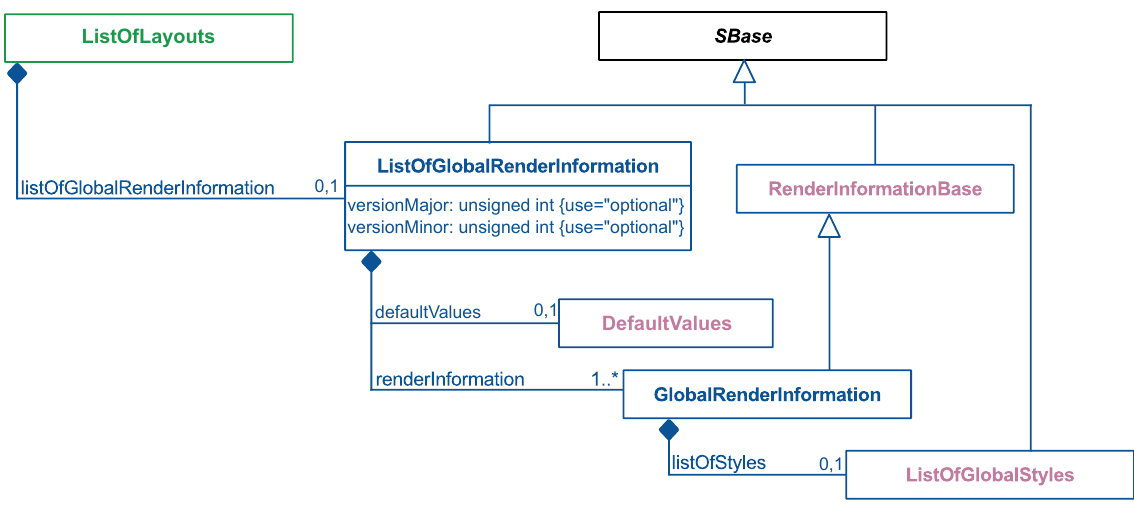
Figure 3: A UML representation of the extended ListOfLayouts object for the Render package. See Section 1.4 for conventions related to this